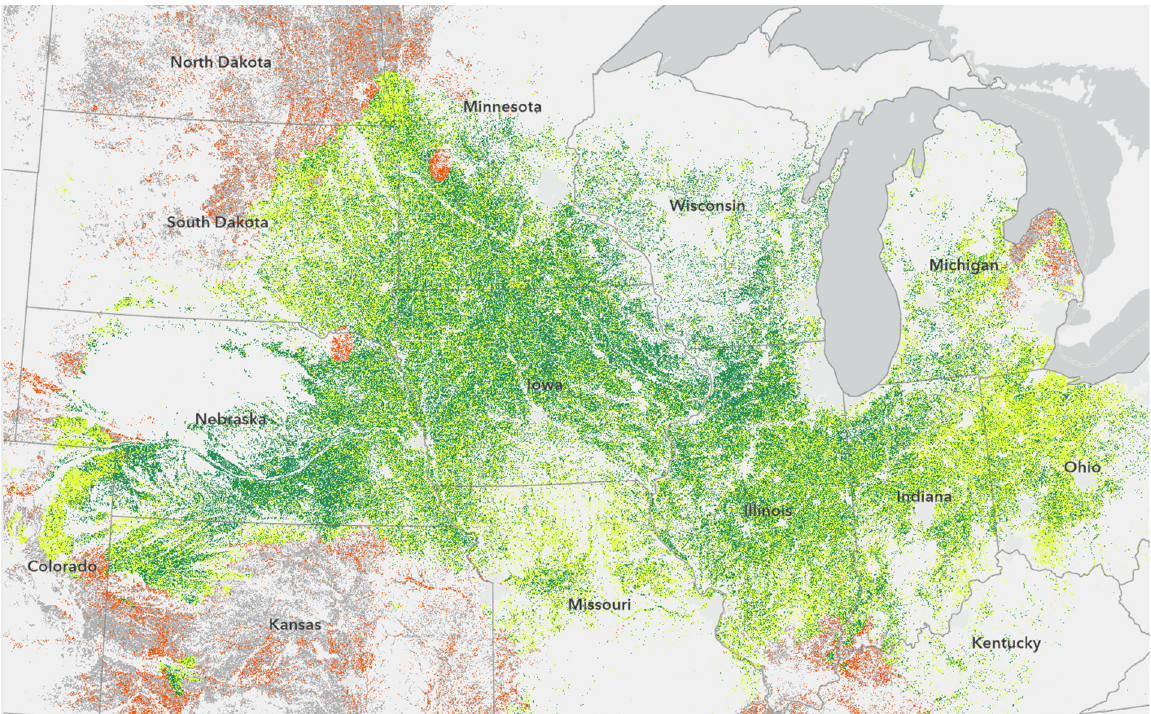
Figure 4. Maxent corn suitability compared with real-world presence/absence data. Areas in green represent suitable presence (true positive); areas in yellow represent suitable absence (false positive); areas in orange represent unsuitable presence (false negative); areas in grey present unsuitable absence (true negative). Maxent shows clearly defined areas of corn suitability in and around areas of high corn presence.